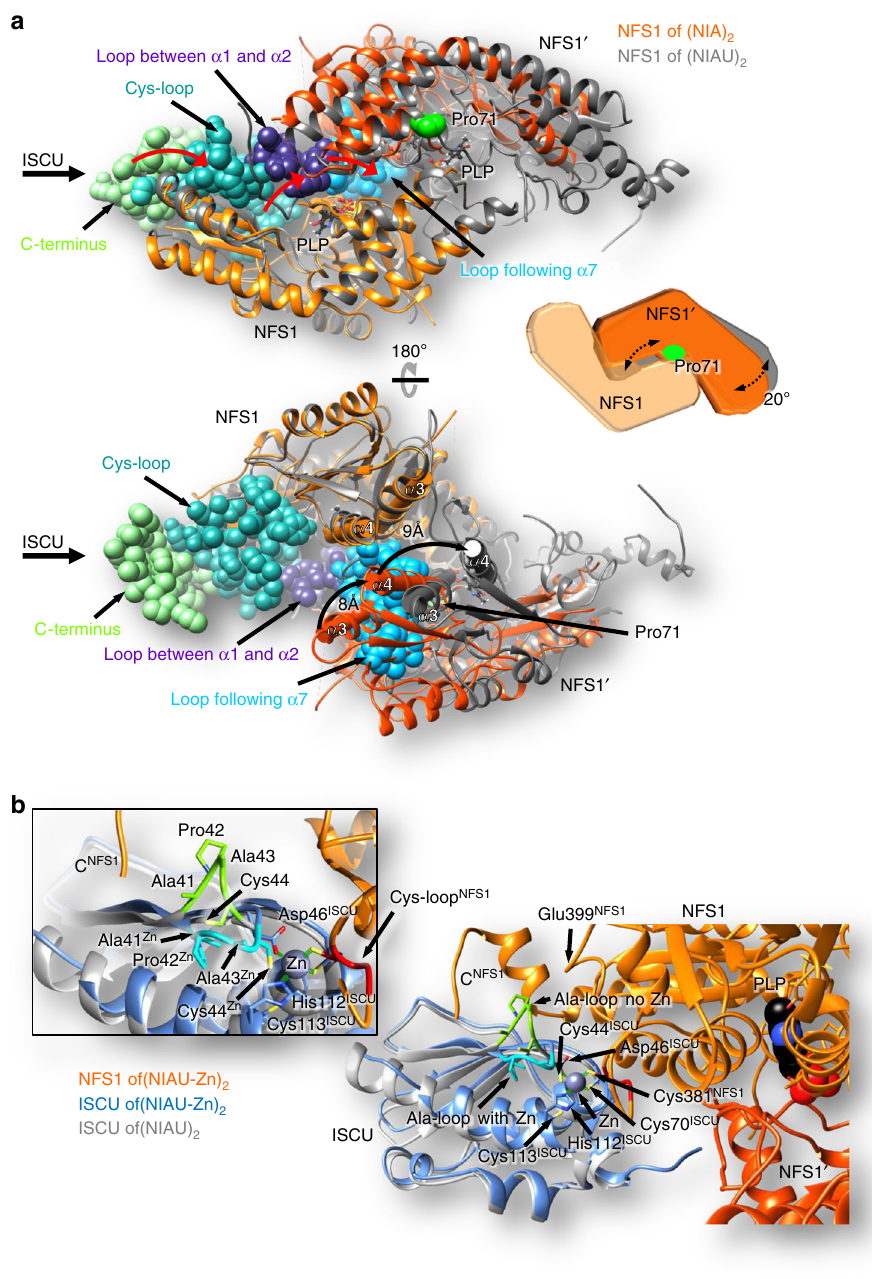
Fig. 2 Conformational changes of NFS1 upon ISCU binding. a The NFS1 dimer rotation visualized by superposition of NFS1 as present in (NIA) 2 (orange) or (NIAU) 2 (gray). The rotation pivot point is located close to Pro71 (green) in front of the PLP moiety (black). Regions of NFS1 disordered in (NIA) 2 , yet structured in (NIAU) 2 complexes are shown by spheres. They connect the ISCU binding site and helices α 3 and α 4 in a “ domino-like ” fashion (red arrows). The tips of helices α 4 in the (NIA) 2 complex are close together and provide new stabilizing interactions in place of disordered regions. As a result of ordering due to ISCU binding, NFS1 helices α 3 and α 4 re-orient by 8 Å and 9 Å, respectively and the ‘ standard ’ interface is recreated. The cartoon illustrates the movement of the NFS1 dimer. b Mode of ISCU binding to NFS1 in the (NIAU) 2 and (NIAU-Zn) 2 complexes. Upon Zn binding to the active-site Cys381 NFS1 , the Cys-loop (red) becomes fully structured. Additionally, Zn is coordinated by Asp46, Cys70, and His112 of ISCU. The Ala-loop (Ala41- Cys44) of ISCU (cyan in (NIAU) 2 and green in (NIAU-Zn) 2 ) is rearranged upon Zn binding